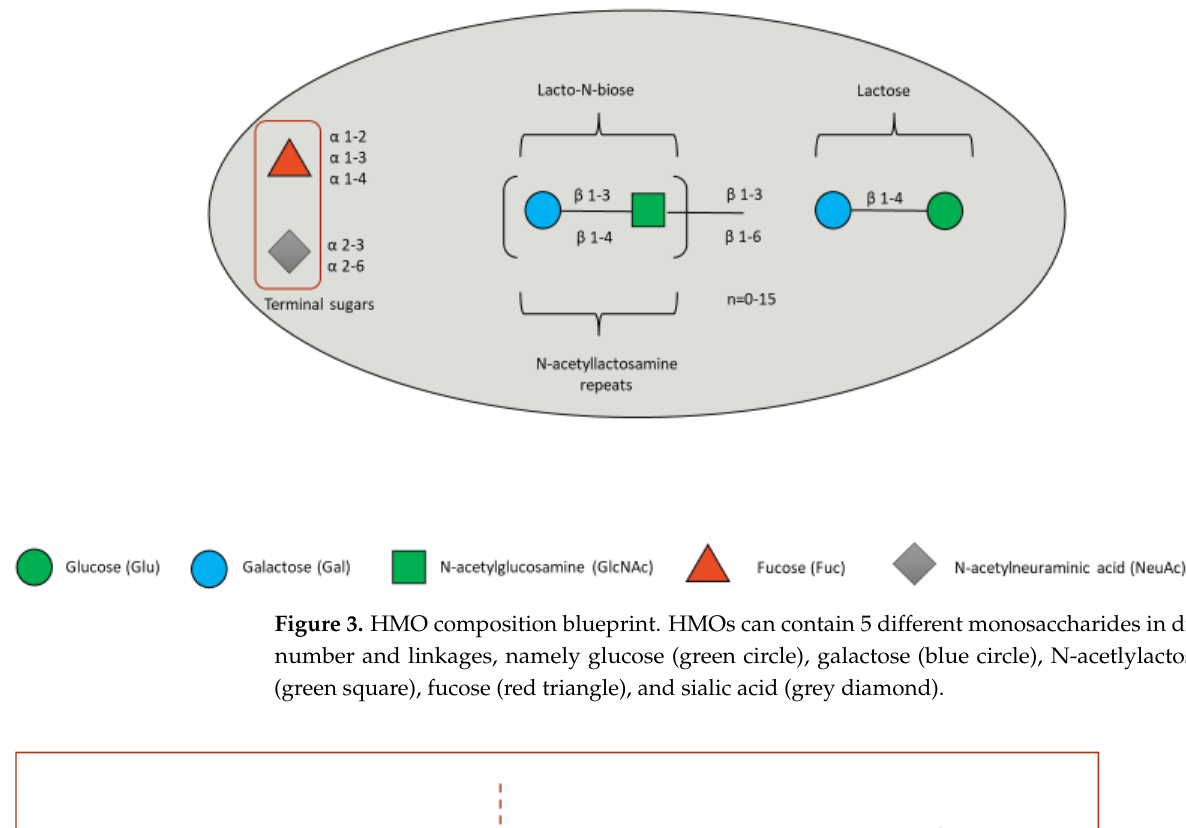
Figure 4. Small fucosylated ( left ) and sialylated HMOs ( right ). Lactose can be fucosylated or si-